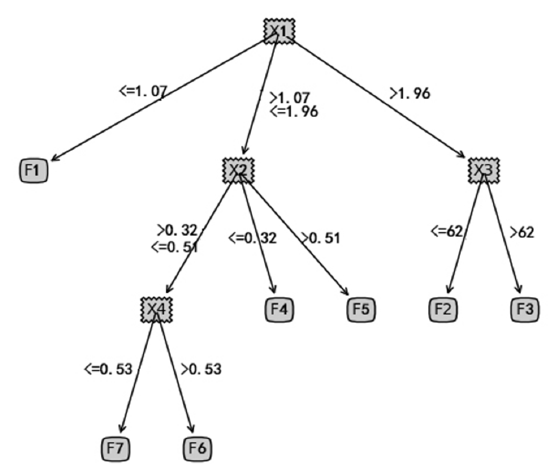
Figure 3. K_C4.5 decision tree classification result.